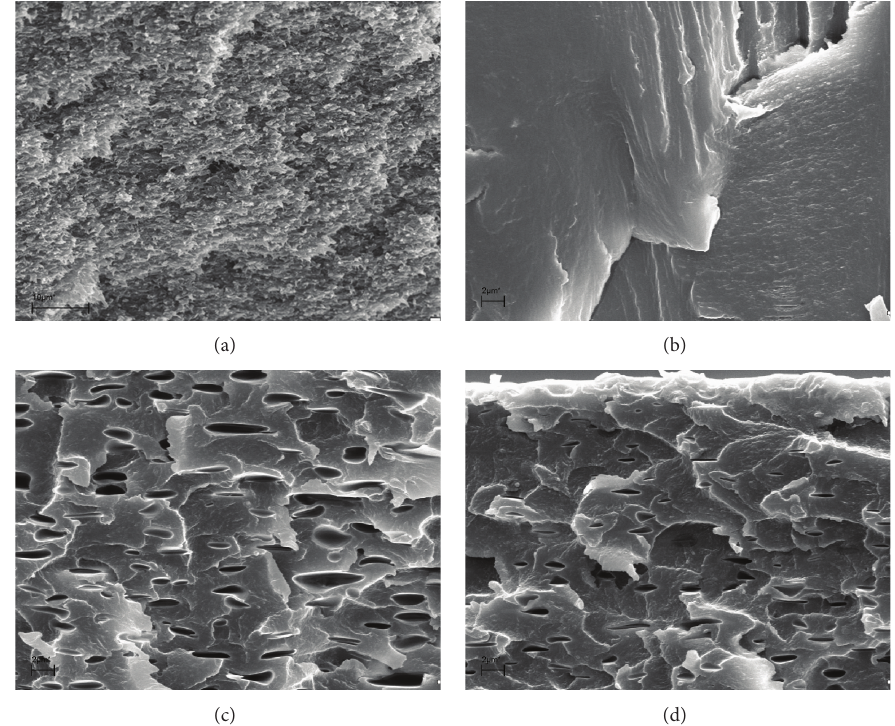
F 9: S�M images: (a) CAP (magni�cation 5000, scale bar: 10